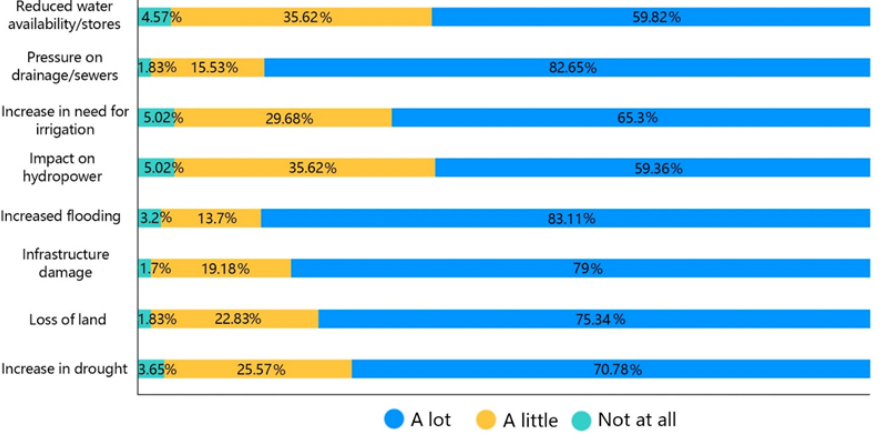
Figure 11. Participants ’ views on hazards of climate change and coastal/flood vulnerability.